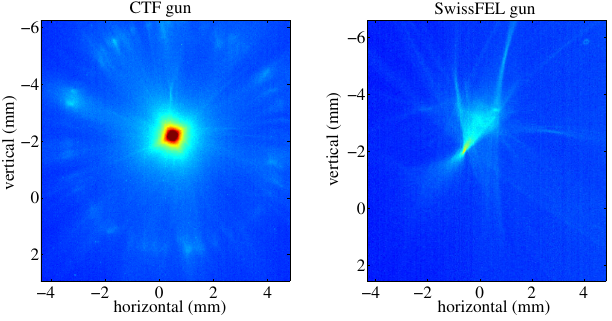
FIG. 18. Example images of dark current at nominal conditions on a YAG ∶ Ce screen near the gun exit for the CTF (left) and SwissFEL (right) guns.